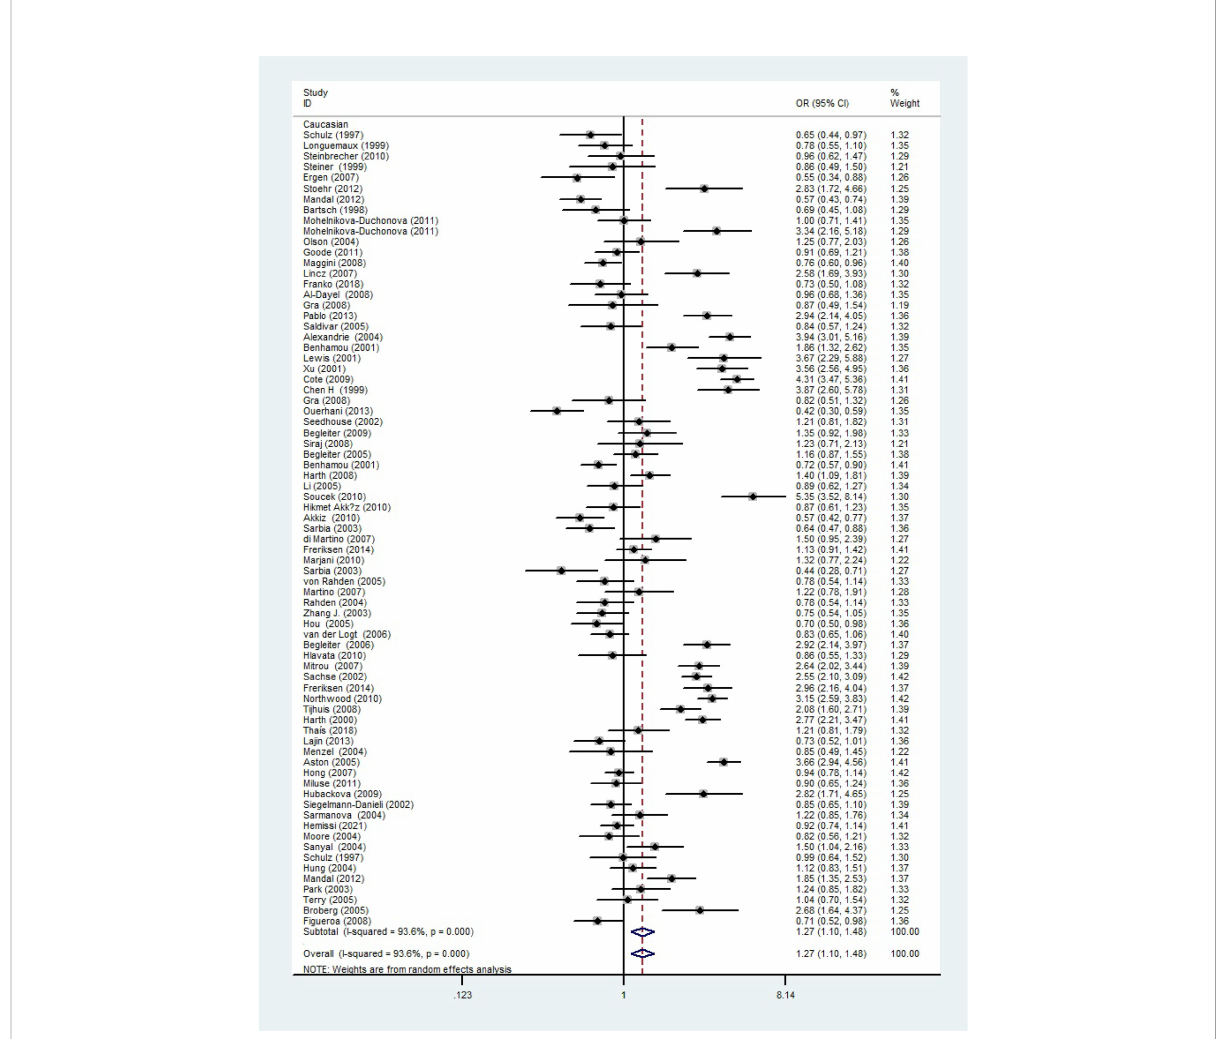
FIGURE 6 The relationship between cancer risk and the rs1800566 polymorphism in the NQO1 gene in Caucasians (C-allele vs. T-allele model). There were signi fi cantly increased association between NQO1 polymorphism in Caucasian population. The squares and horizontal lines correspond to the study-speci fi c OR and 95% CI. The area of the squares re fl ects the weight (inverse of the variance). The diamond represents the summary OR and 95%